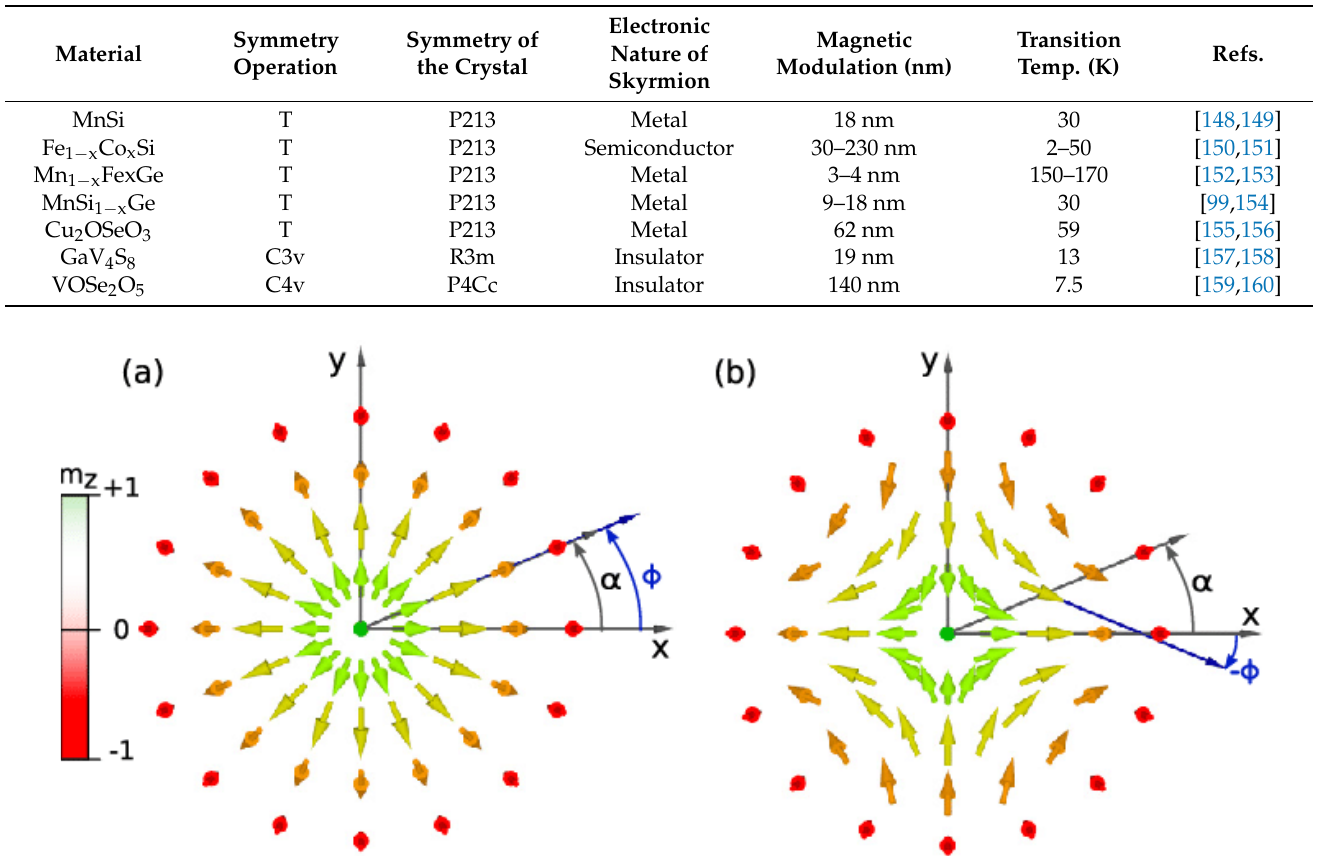
Table 5. List of skyrmions materials.